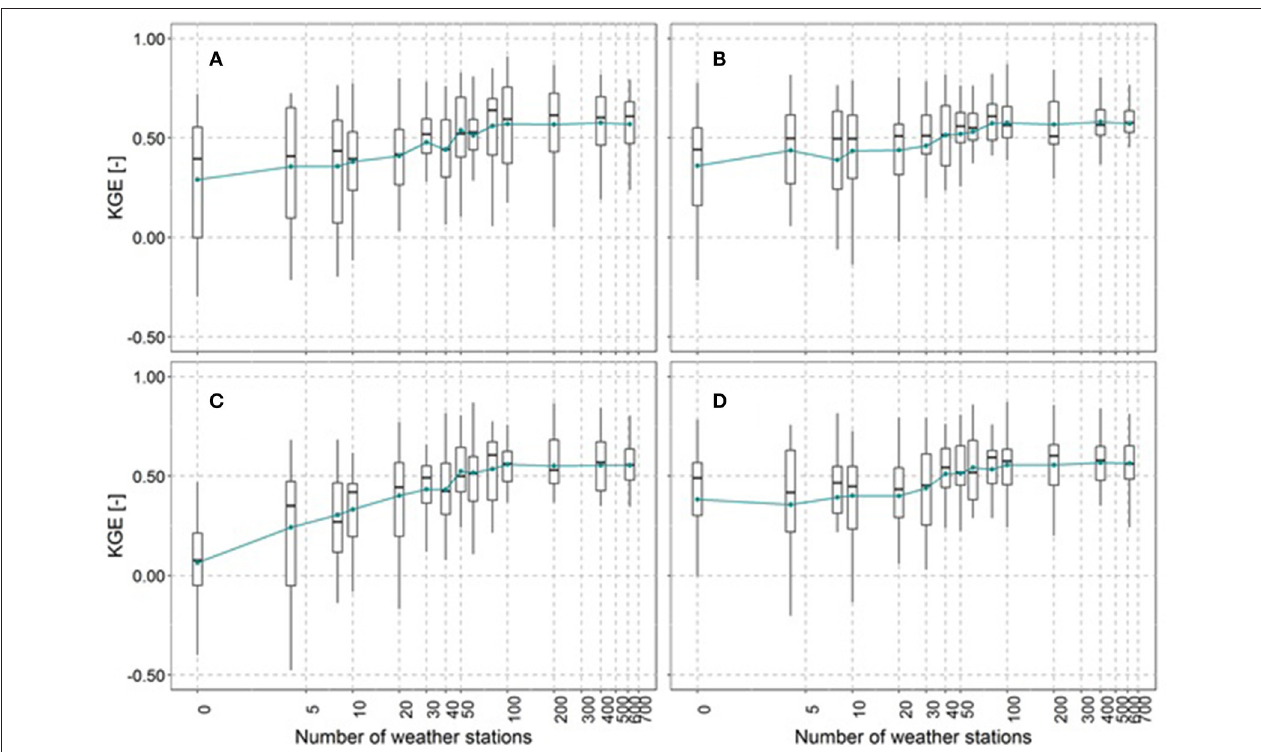
FIGURE 10 | KGE values (y-axis) between daily simulated and observed discharge when the model was forced with (A) CMORPH, (B) MSWEP, (C) PERSIANN, and (D) TRMM precipitation datasets at 1km resolution for the 2000–2012 period, derived with different number of weather stations (x-axis; 0, 4, 8, 10, 20, 30, 40, 50, 60, 80, 100, 200, 400, and 616). Logarithmic scale was used for the horizontal